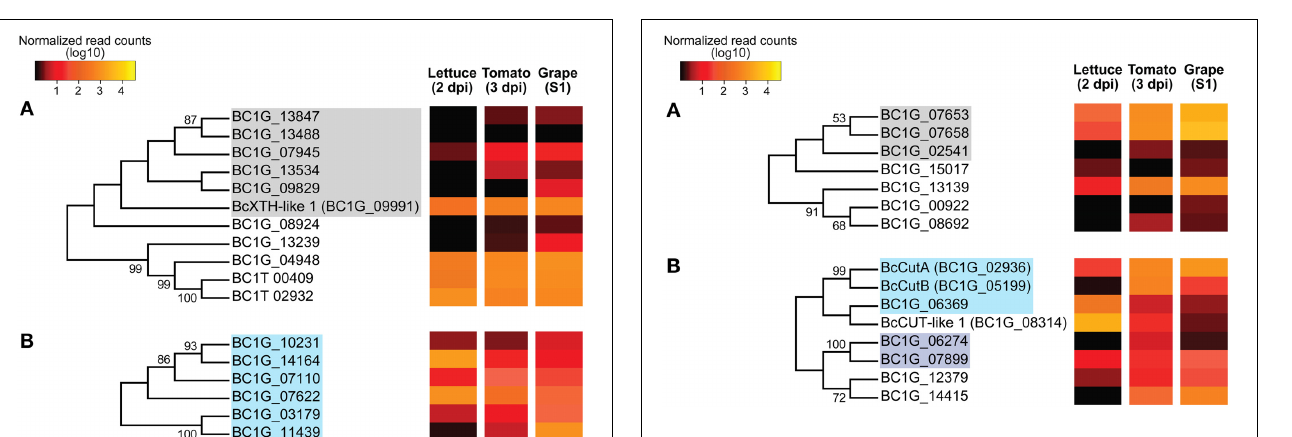
FIGURE 7 | Phylogenetic tree and expression levels of putative copper-dependent lytic polysaccharide monooxygenases (LPMOs) and cutinases. Bootstrap consensus trees inferred from 1000 replicates using the Neighbor-Joining method for the Botrytis CAZymes with predicted signal peptides in the AA9 (A) and CE5 (B) subfamilies. The percentages ( > 50%) of replicate trees in which the associated taxa clustered together in the bootstrap test are shown next to the branches. Colored-boxes in the phylogenetic trees indicate protein tribes ( > 2 members) determined by BLASTp alignments ( e -value < 1e − 6) and Tribe-MCL (Enright et al., 2002). In (A) , gray box = tribe 13. Boxes in (B) light blue = tribe 15 and purple = tribe 31 (Supplemental Table S2). The colors in the heat maps represent the number of DESeq-normalized transcript counts (log10) of the Botrytis genes in infected lettuce leaves, ripe tomato fruit and grape